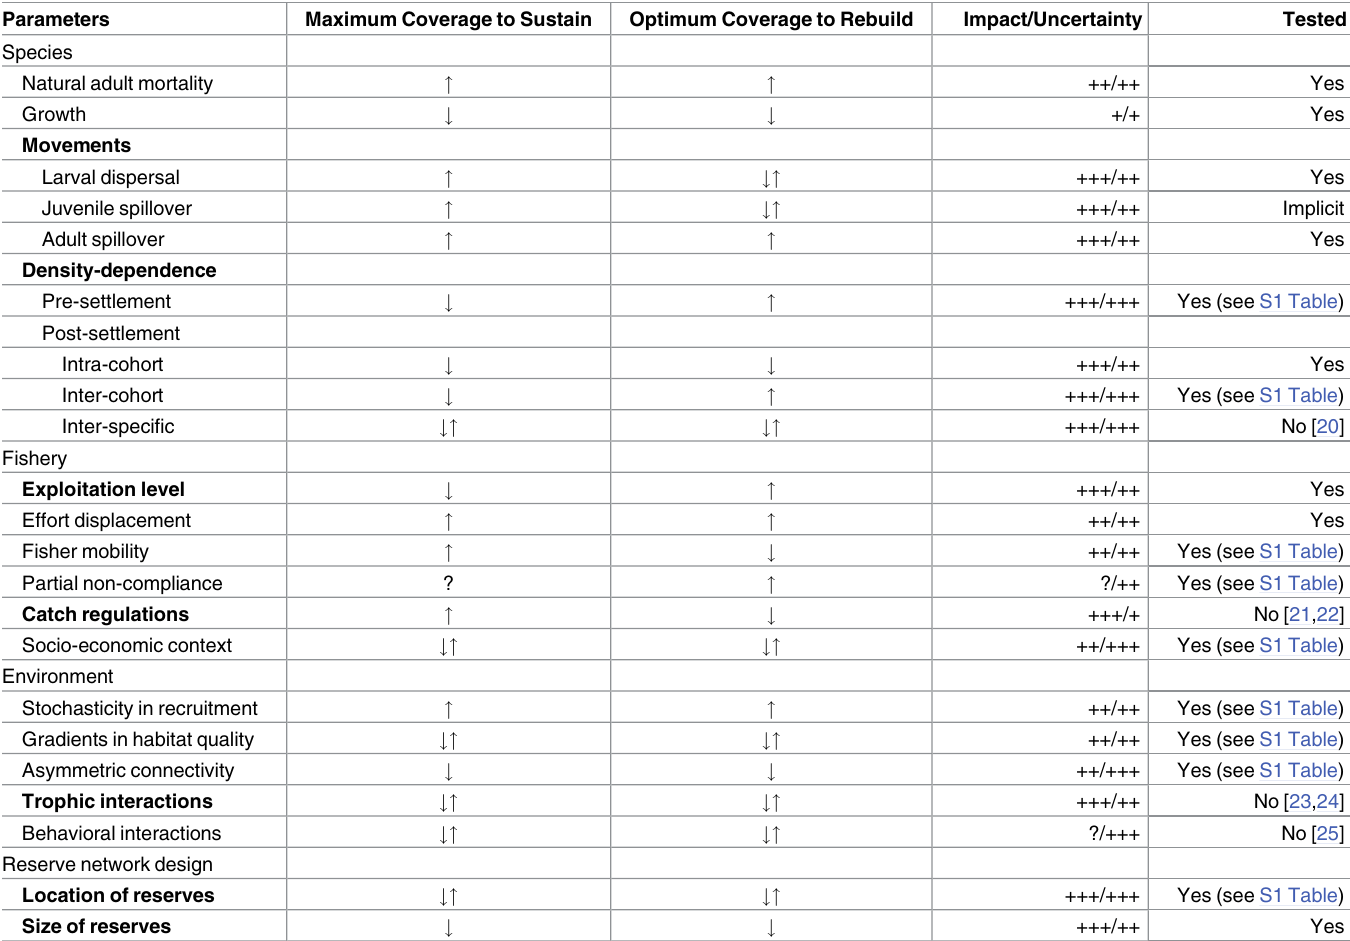
Table 1. Key drivers of the fishery functioning of marine reserves. Arrows highlightthe net impact of an increasein parameter value on the maximum reserve coveragefor biodiversity conservation without fisheries costs (sustain fisheries) and the optimum reserve coverageto benefit fisheries (rebuildfisher- ies). Plus signs rank the relative strengths and uncertainties of impacts: + low, ++ medium, +++ strong. The strongest drivers of fishery impacts are marked in bold. See text and S1 Table for